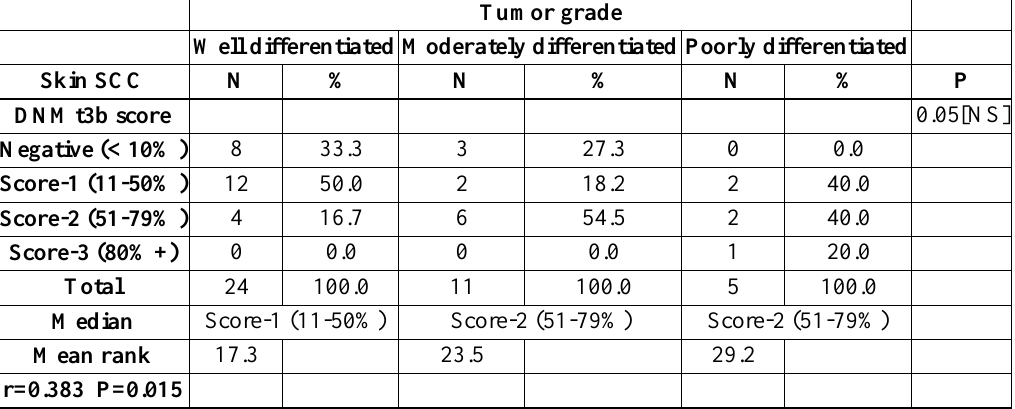
Table 6: The difference in median score category of DNMT3B among the 3 tumor grades among cases with Skin SCC. Tumor